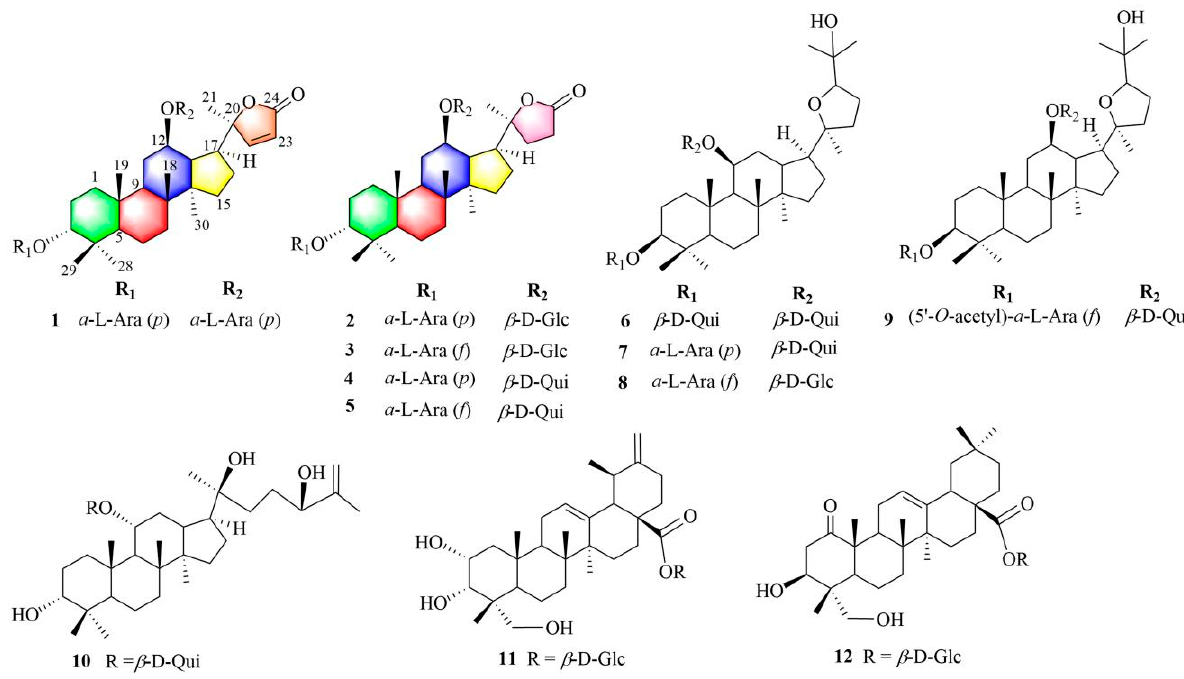
Figure 1. Structures of compounds 1 – 12 isolated from C. paliurus